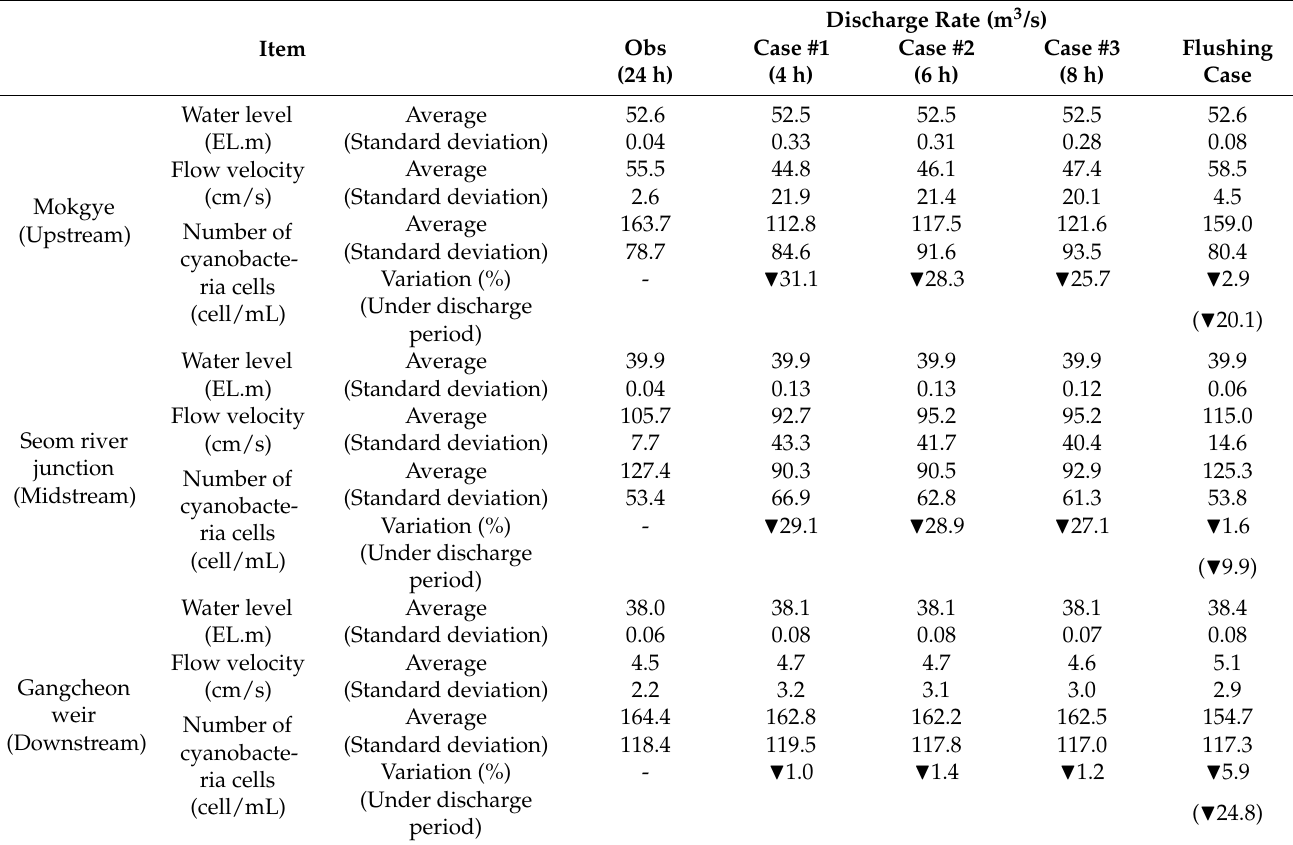
Table 5. Simulation result of